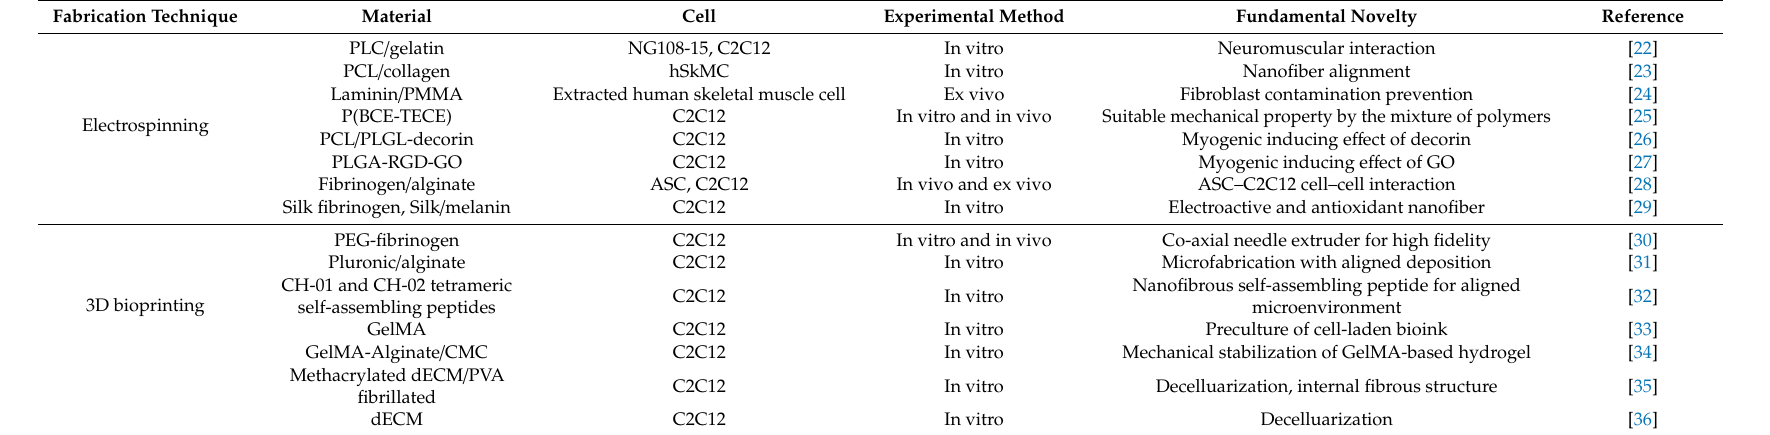
Table 1. Recent research on skeletal muscle tissue engineering enabled by electrospinning and 3D